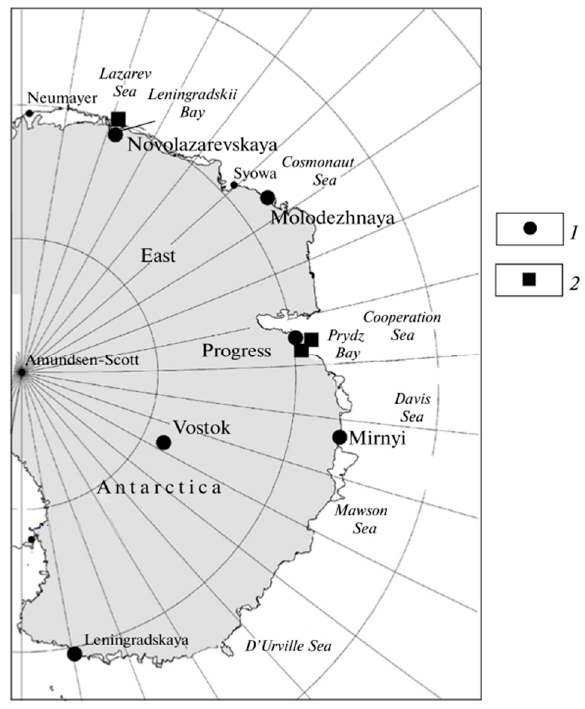
Figure 10. Map of Antarctica: 1— location of Russian stations, 2— sampling localities.